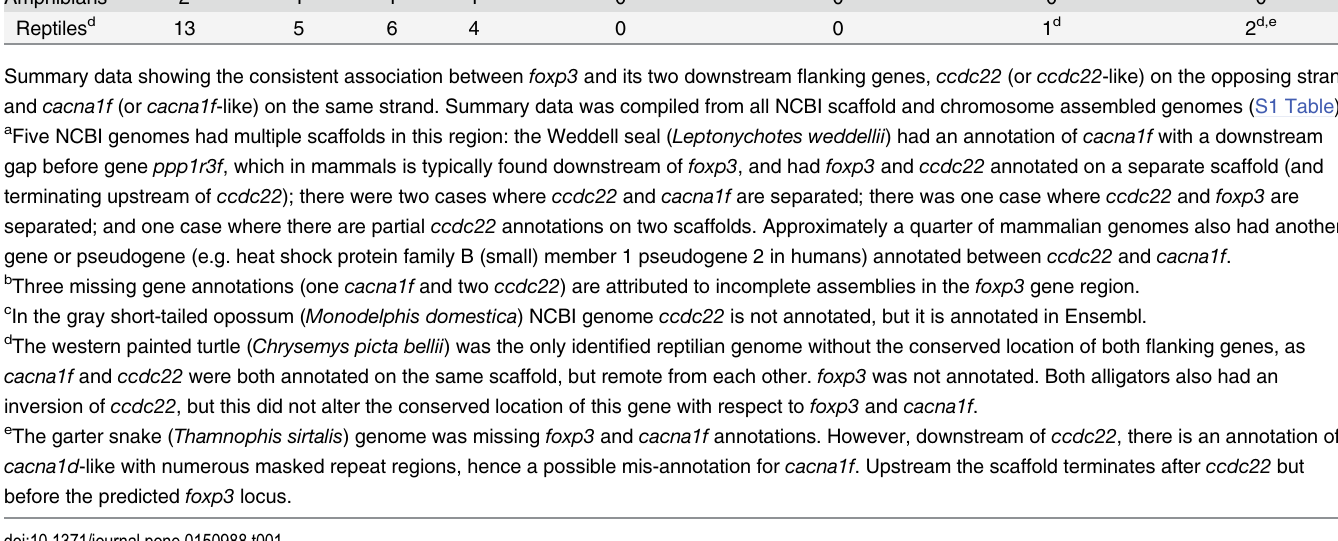
avian genomes containing both cacna1f (or cacna1f -like) and naa10 (or naa10 -like). These three remaining genomes belonged to the ground tit, peregrine falcon ( F . peregrinus ) and saker falcon ( F . cherrug ). Of note, all three species had exceptionally high quality genomes, combin- ing a small numbers of scaffolds ( < 7500), high scaffold N50 values ( > 3.9 mBP) and uncom- monly high genome coverage ( > 95x) compared to other avian species, as summarised in Table 2. Fifty-four of the 61 available avian genomes, including all three birds with identifiable FoxP3, were sequenced with Ilumina Hiseq, which may be prone to significant errors in certain regions of the genome [43]. Moreover, genome assemblies are often incomplete and error- prone in general [44 – 46], and the FoxP3 region of the genome presumably presents particular challenges in birds and indeed a number of reptiles.